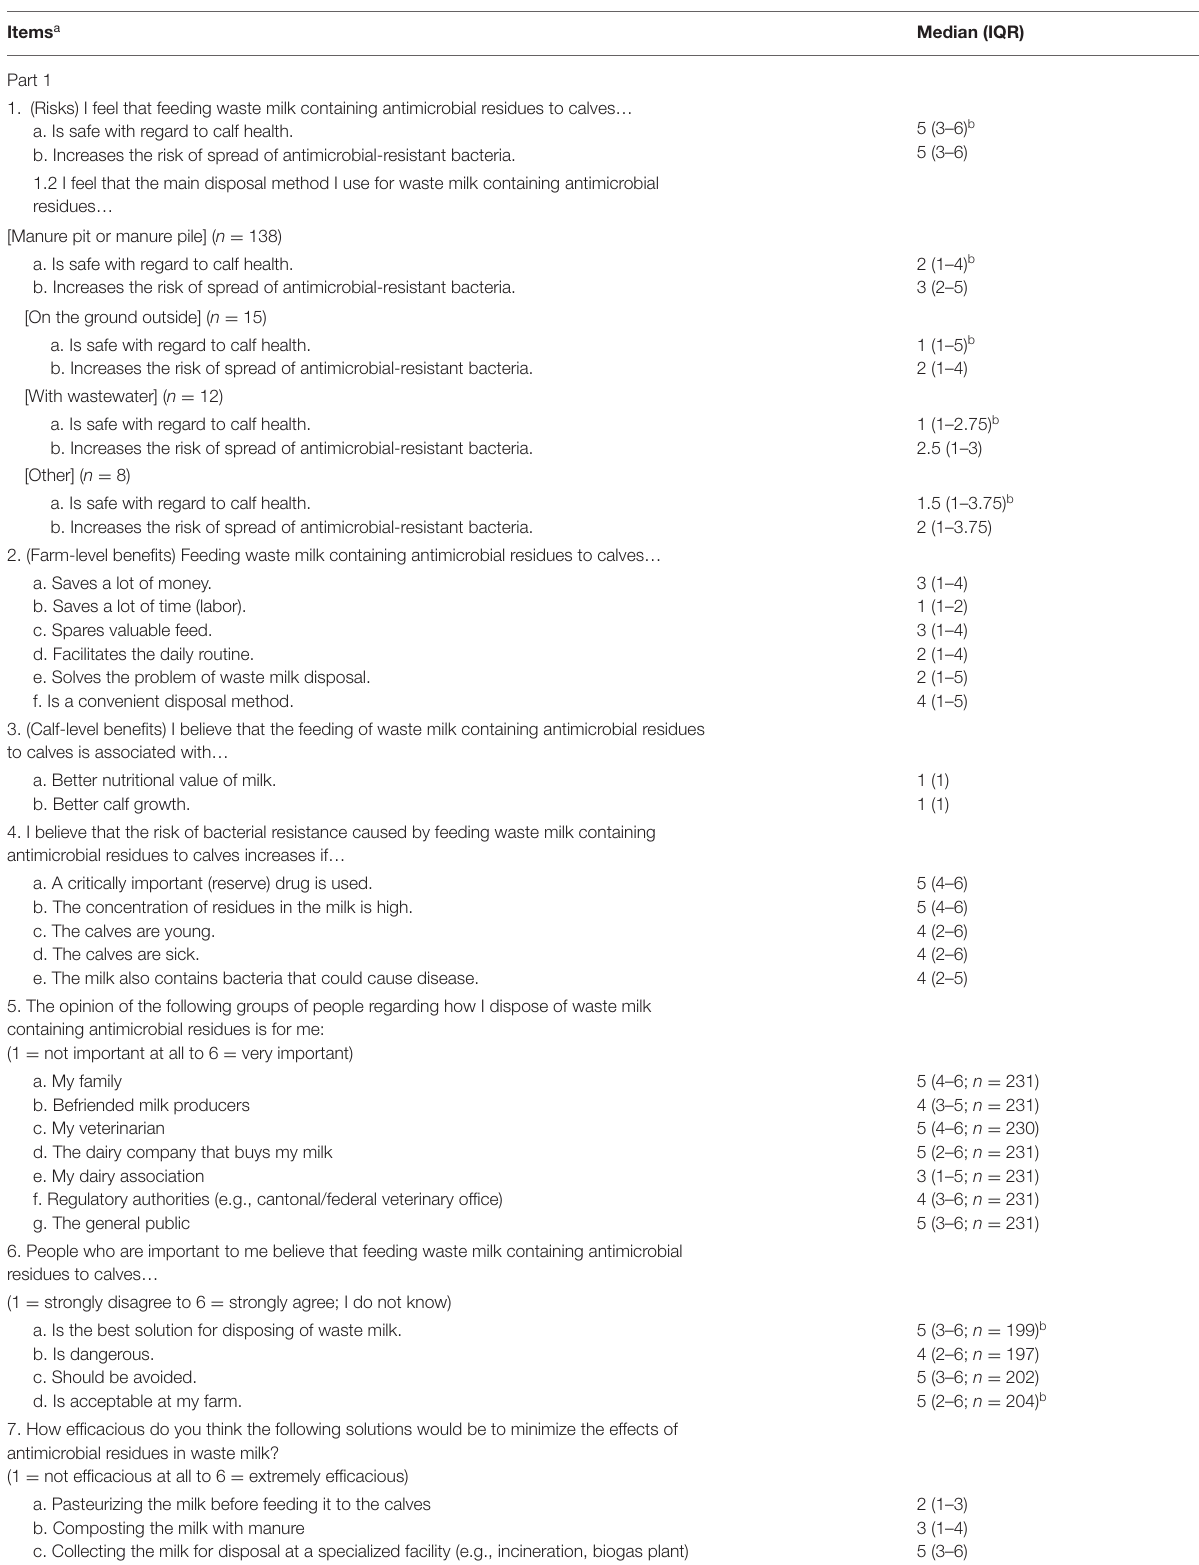
TABLE 1 | Questionnaire items related to perceptions (6-point Likert-scale) and personal values (9-point Likert-scale), with median values and interquartile range (IQR), using responses from 233 dairy producers (unless indicated otherwise, for non-mandatory questions). Items